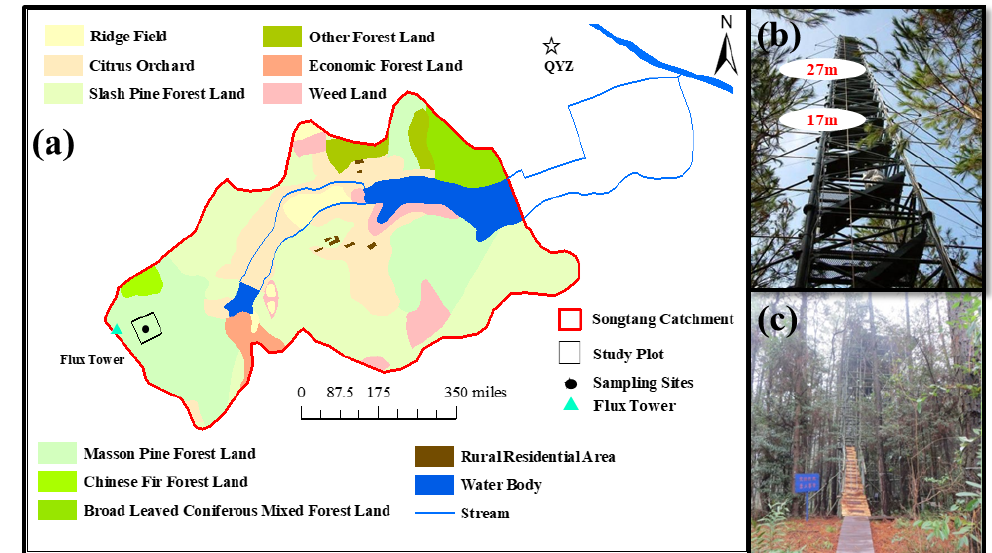
Figure 1. ( a ) Map of study plot and sampling sites, ( b ) photos of the flux tower, and ( c ) photos of the bamboo tower for plant sampling.